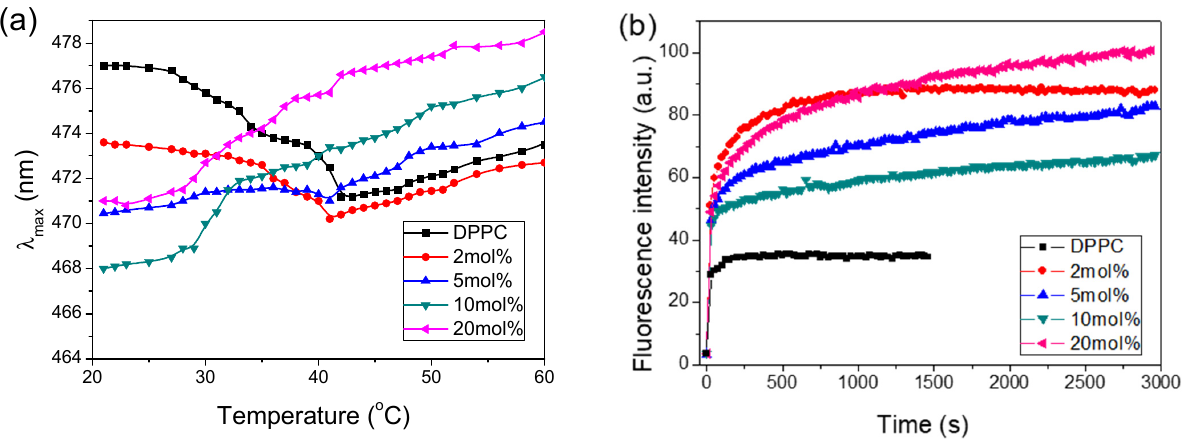
Figure 2. ( a ) Positions of ANS emission maxima ( λ max ) versus temperature with increasing presence of CT in 0.08 mg/mL DPPC during heating from 20 ◦ C to 60 ◦ C; ( b ) kinetics of ANS transport into the DPPC membrane at 25 ◦ C. The concentration of CT is given in the legend.